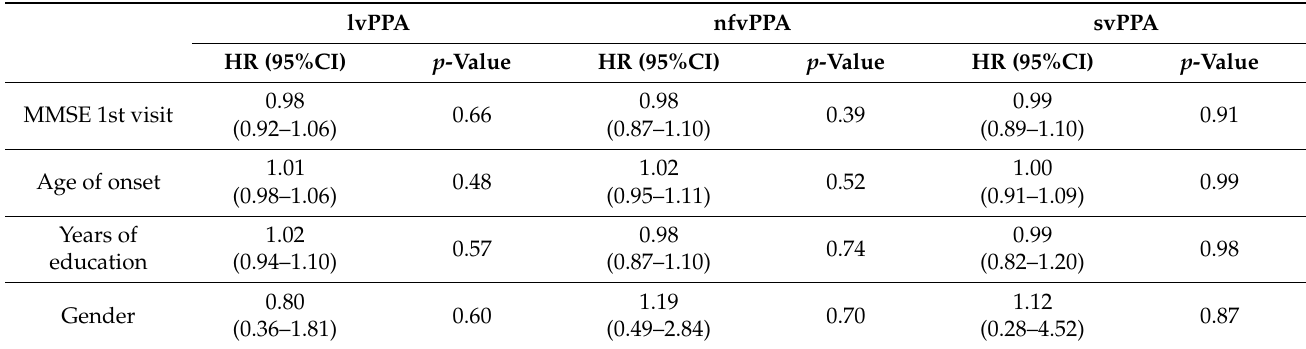
Table 4. Hazard ratios since